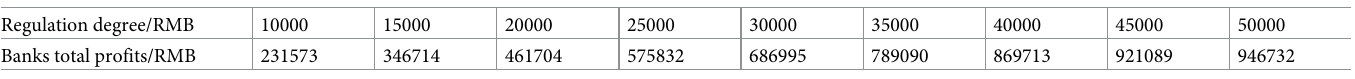
Table 2. The banks total profits of the different regulation degree.